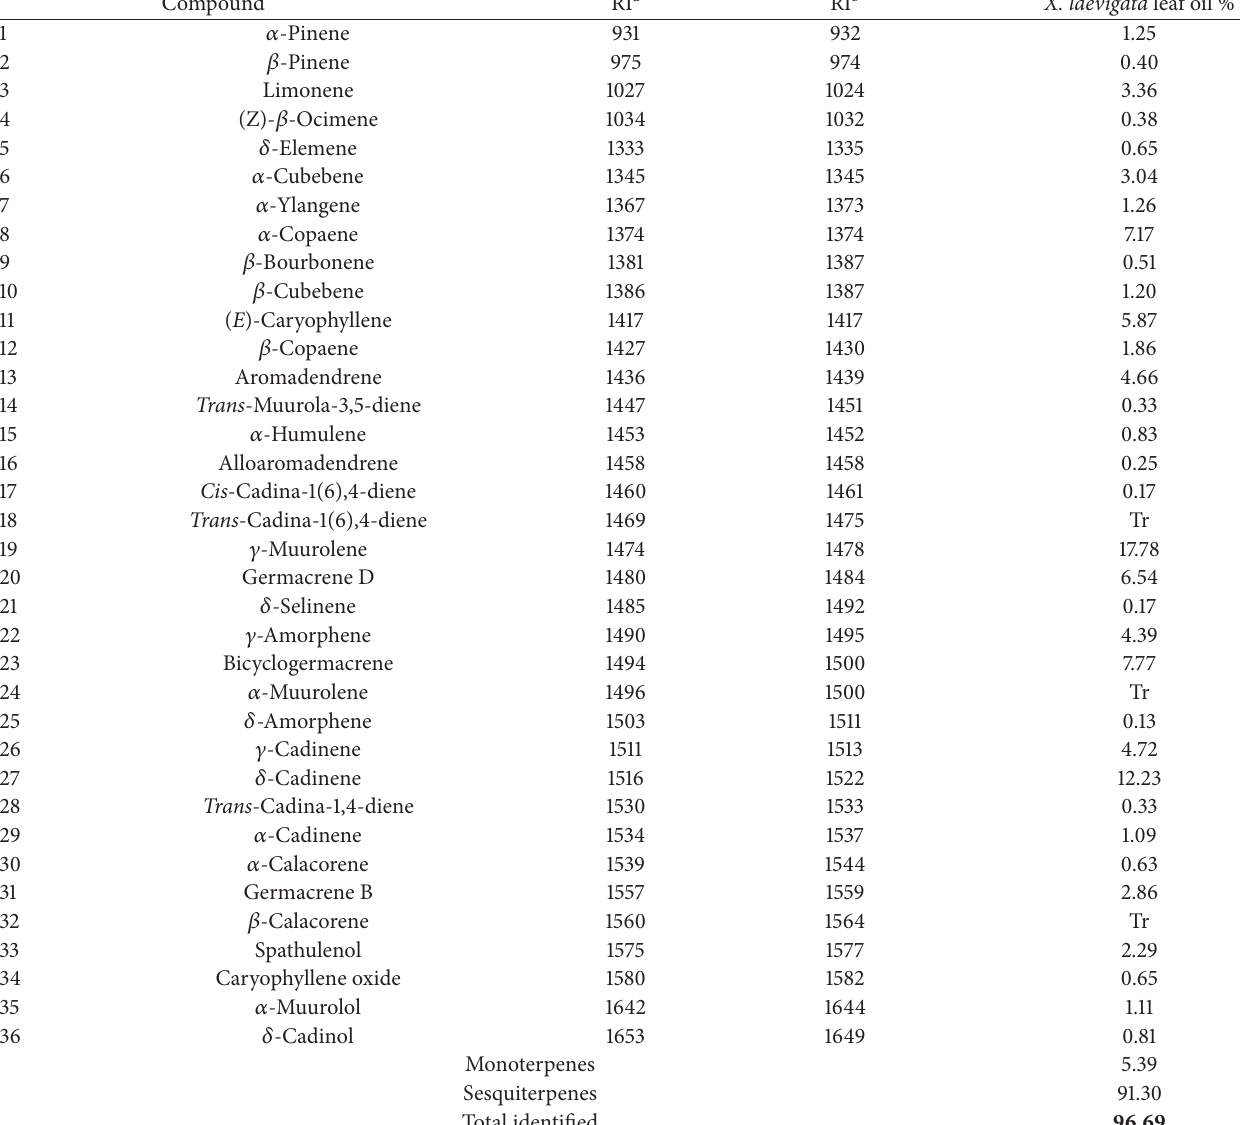
Table 1: Essential oil composition from the leaves of X. laevigata .